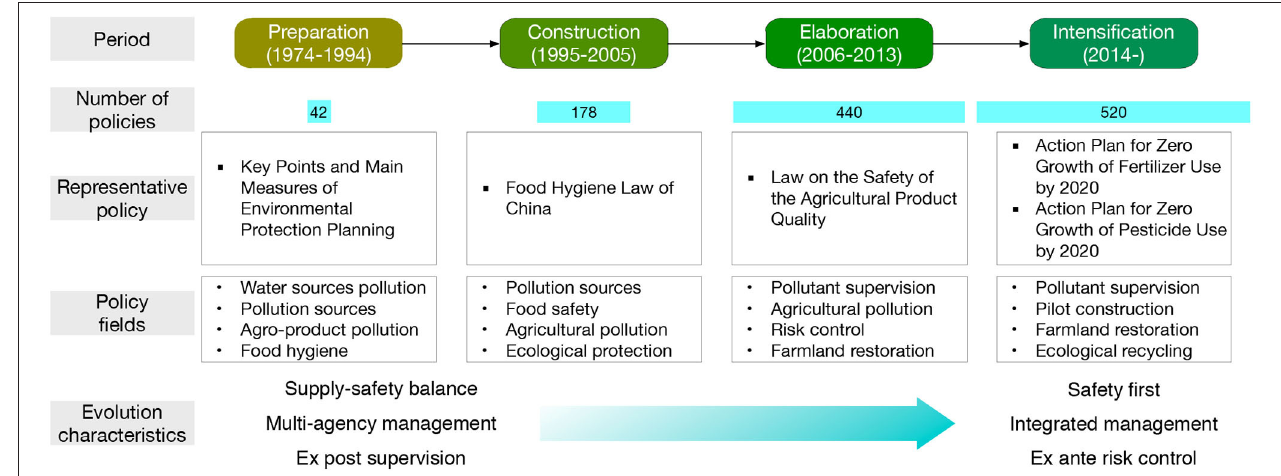
FIGURE 10 | The policy evolution on pollution-induced food safety of China.